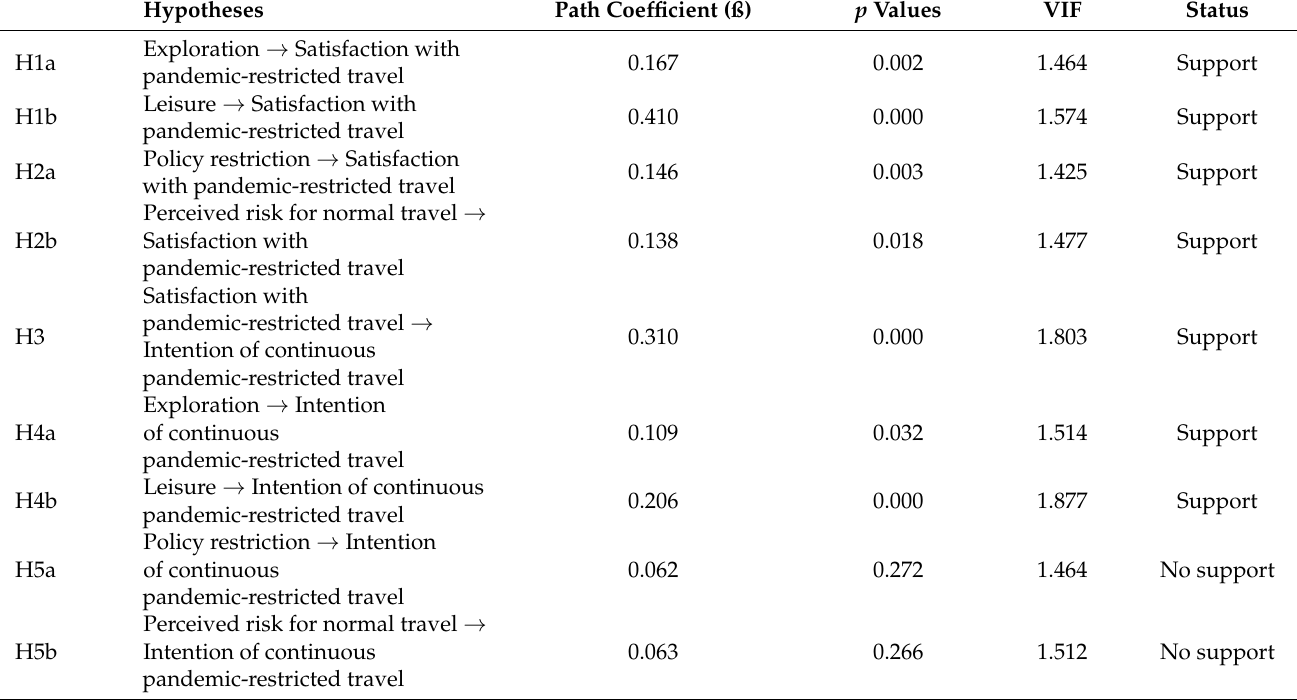
Table 5. Structural equation